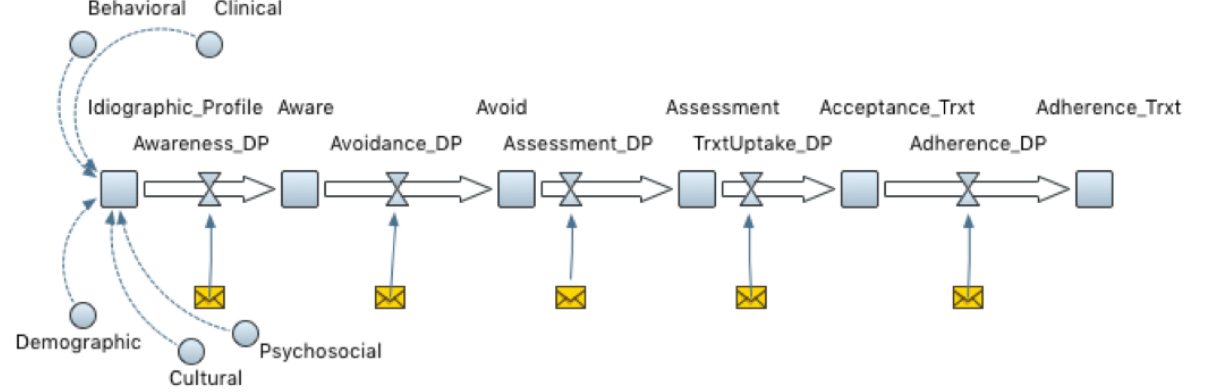
Figure 2. Representation of idiographic profile, meta-cognitive/mind map and care journey for an individual to increase adherence. The care continuum journey map from awareness, avoidance, assessment, acceptance, and adherence. The envelope icon represents personalized messages delivered at critical decision points to individuals to optimize acceptance and adherence treatment at each juncture of care continuum journey